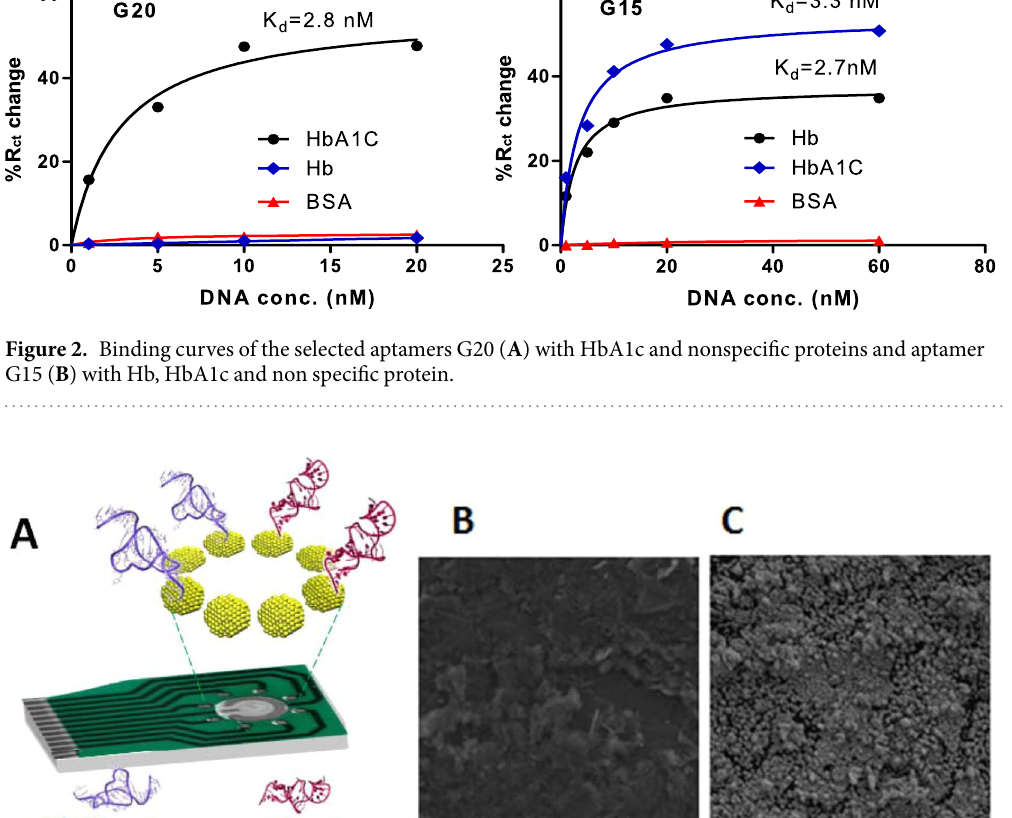
Clone number Aptamer sequence